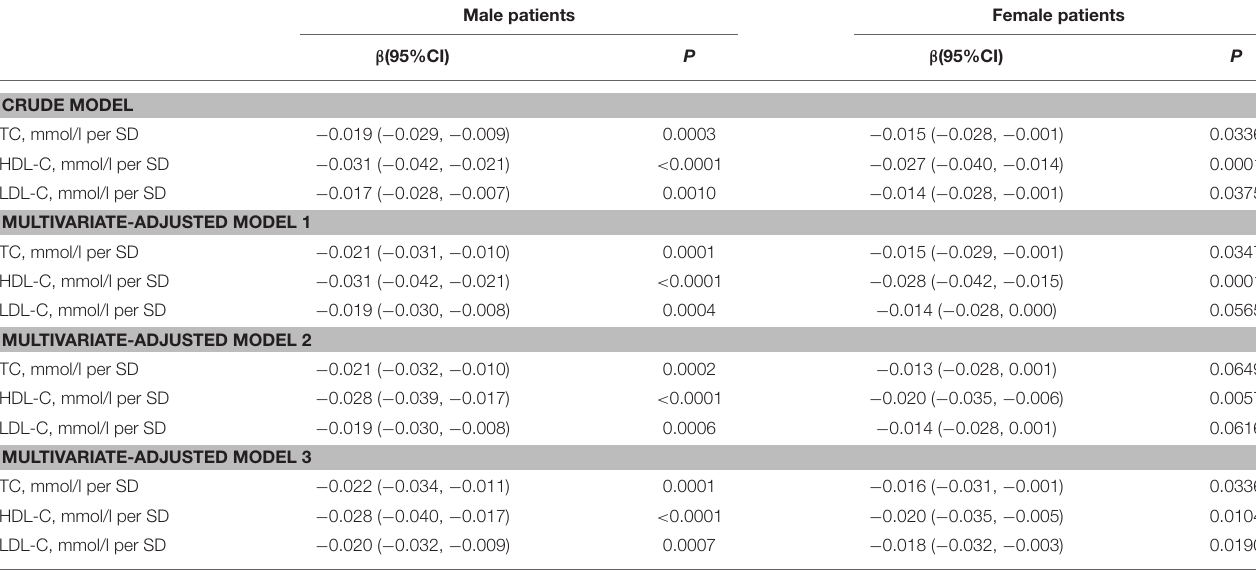
TABLE 2 | Multivariate regression for effect of TC, HDL-C, and LDL-C on total lumbar BMD.